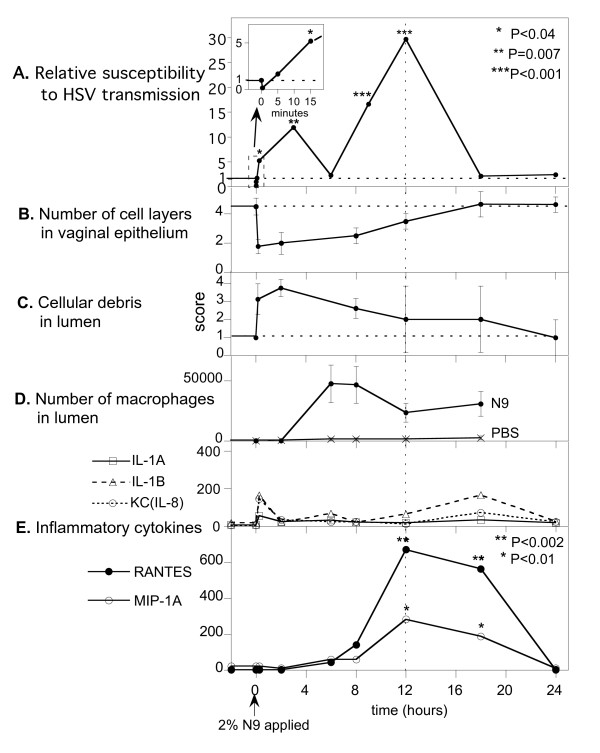
Vaginal HSV-2 susceptibility and toxic effects vs time after a single dose of 2% N9. A. Relative susceptibility is the effective Infectious Doses the inoculum delivers in N9-exposed mice normalized to the Infectious Doses it delivers in control (PBS) mice. The single dose of N9 produced three successive phases in susceptibility, a brief initial protective phase (reduced susceptibility) followed by two distinct phases of markedly increased susceptibility. P values were determined by Fisher's exact two-sided test comparing the numbers of animals infected and uninfected in the test animals vs. the corresponding numbers in control animals treated only with PBS. B-E. Error bars indicate standard deviations around the mean. Concentrations of inflammatory cytokines are indicated by geometric means normalized with respect to those for PBS controls. See legend for Fig. 6 for geometric means of PBS controls. B, C. Data obtained from histology sections from four locations distributed along the length of the vagina. The score in C is a semi-quantitative evaluation of the amount of visible cellular debris in the vaginal lumen. For each point in B and C at 10 min, 2, and 8 hours, P values were <0.001 with respect to PBS control values. (n = 8) D. P values for all times points from 6 to 18 hours were <0.001 with respect to PBS control values. (n = 20) D, E. Data obtained from vaginal lavage samples.